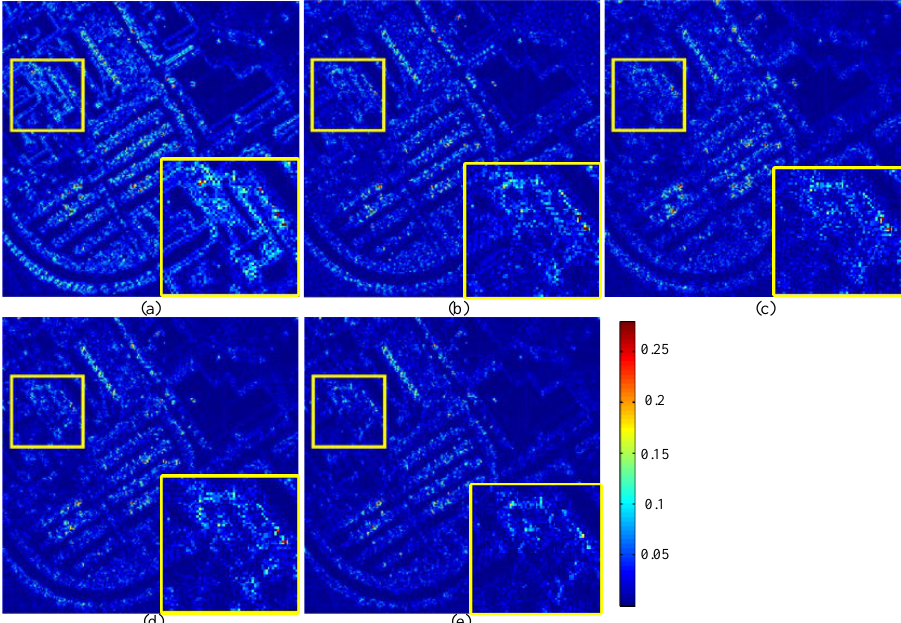
Figure 7. The residual maps on Pavia University by an upscaling factor of two. ( a ) Bicubic result, ( b ) SSG result [27], ( c ) SRCNN result [40], ( d ) 3D-CNN result [32], and ( e ) the proposed MW-3D-CNN result. The residual maps are displayed by scaling to the minimum and maximum errors.